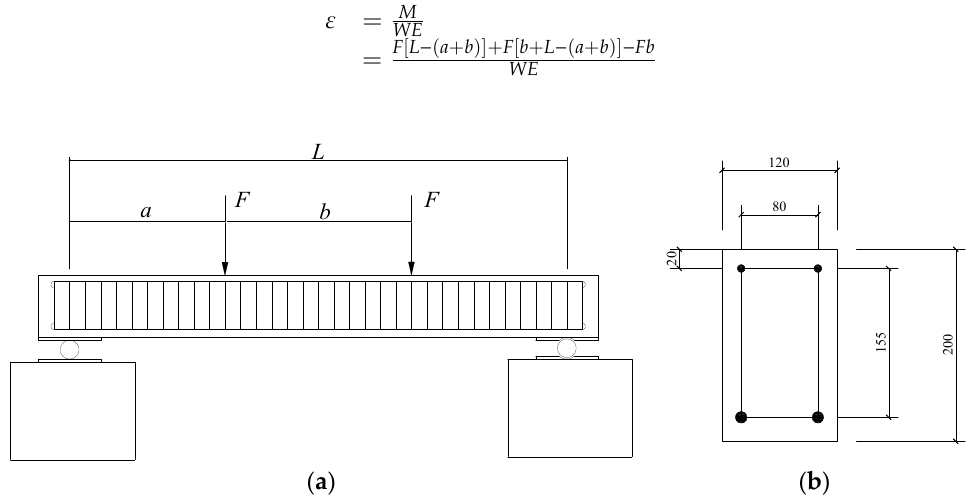
Figure 1. Schematic Diagram of Reinforced Concrete Beam: ( a ) elevation view; ( b ) cross section (Unit: mm).